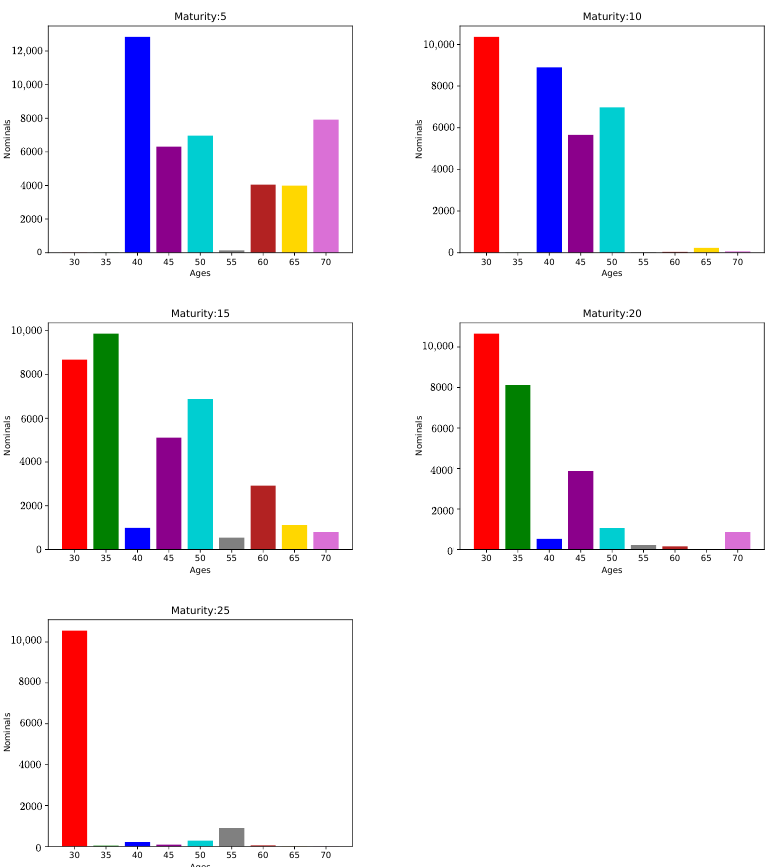
Figure 9. Detailed model points portfolio for each maturity obtained in Example 3.